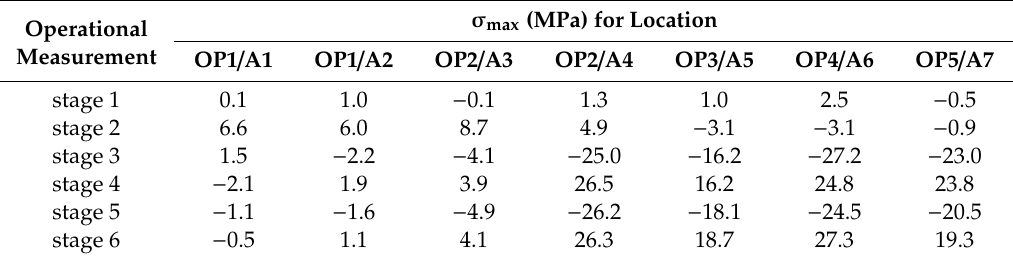
Table 5. Maximum values of normal stresses in the direction of active